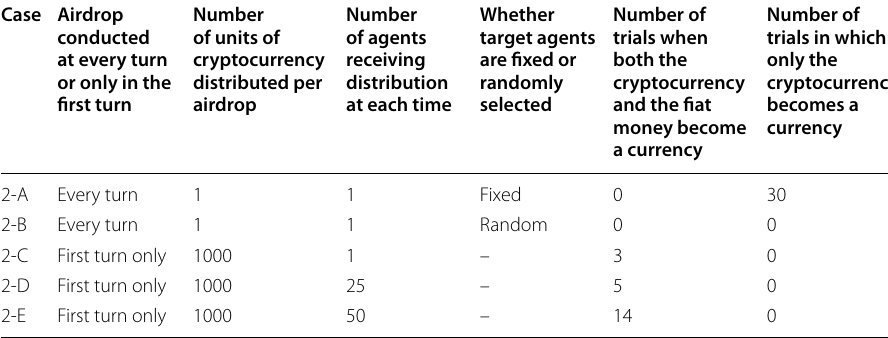
Table 2 Airdrop cases with parameters varied assuming the cryptocurrency good can be selected as a